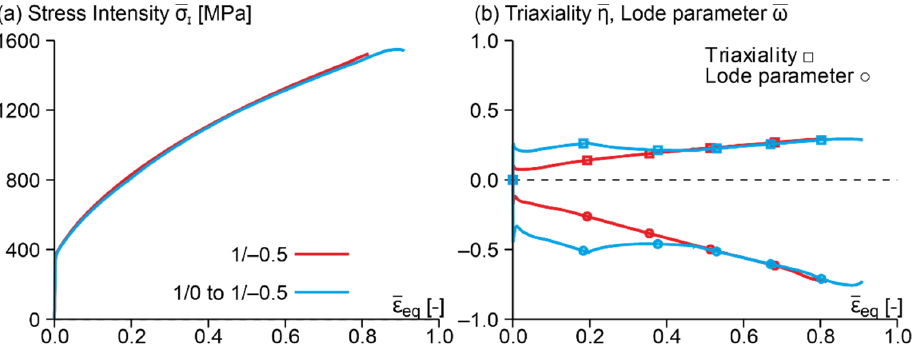
Figure 6. Predicted evolution of mean stress intensity σ I as function of mean equivalent strain ε eq ( a ) as well as mean stress triaxiality η and Lode parameter ω over mean equivalent strain ε eq ( b ) over the cross section of a notch.